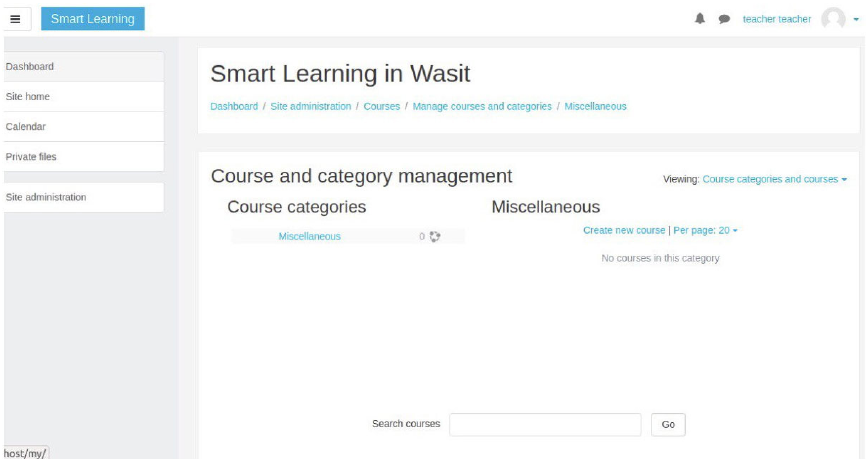
Fig. 4. Create new course